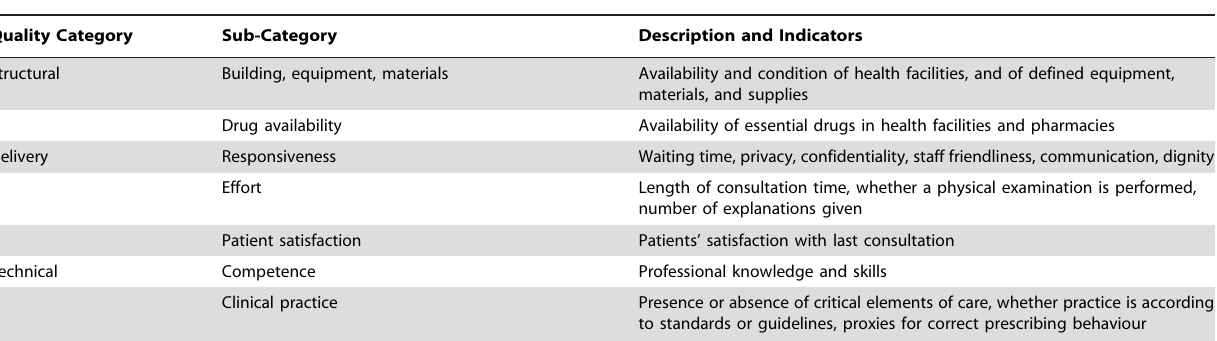
Table 1. Quality categories, sub-categories, and indicators